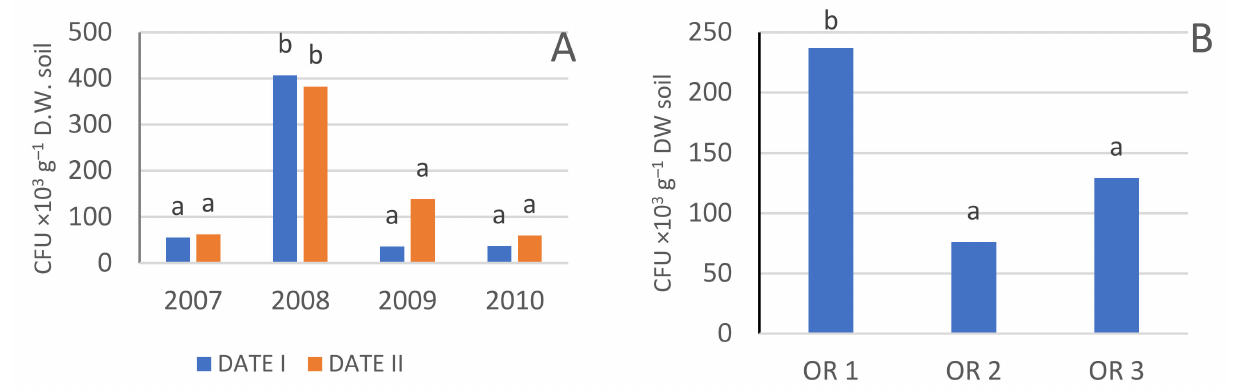
Figure 10. Number of Azospirillum 2007–2010: ( A )—depending on the year and date of sampling; ( B )—depending on the